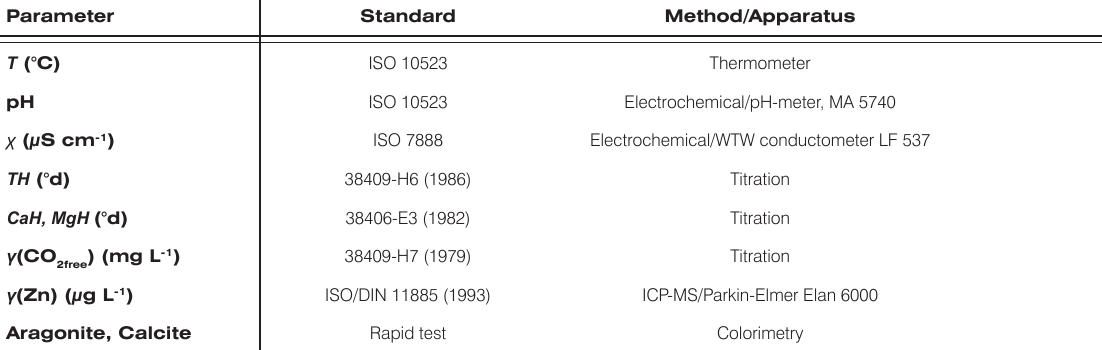
Table 1. The methods and apparatus used for water